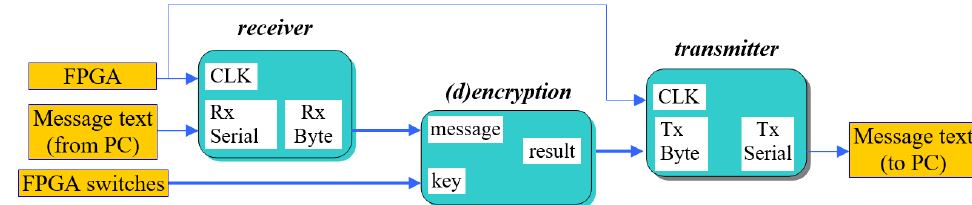
Figure 7. Hardware system block scheme.